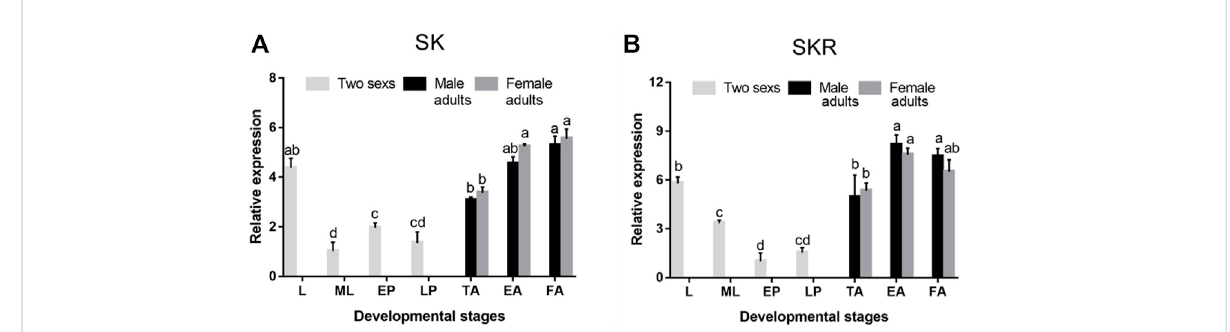
FIGURE 3 Relative mRNA expression levels of SK (A) and SKR (B) in different developmental stages of D. armandi . The relative expression levels were normalizedwith β -actin and CYP4G55 .Differentlowercaselettersindicatesigni fi cantdifferencesatthe0.05level.(one-wayANOVA,Turkeytest).All values are mean ± SE , n = 3. L, larvae; ML, mature larvae; EP, early-stage pupae; LP, late-stage pupae; TA, teneral adults; EA, emerged adults; FA, feeding adults.